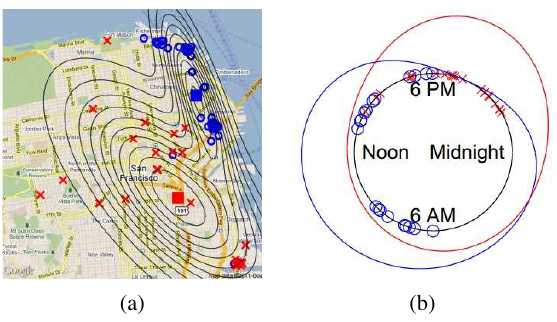
Fig. 9 (a) Spatial model: geographic distribution of check- ins when at home or work place. (b) Temporal model: temporal distribution of check-ins when at home or work place, denoted by red and blue lines, respectively [52]